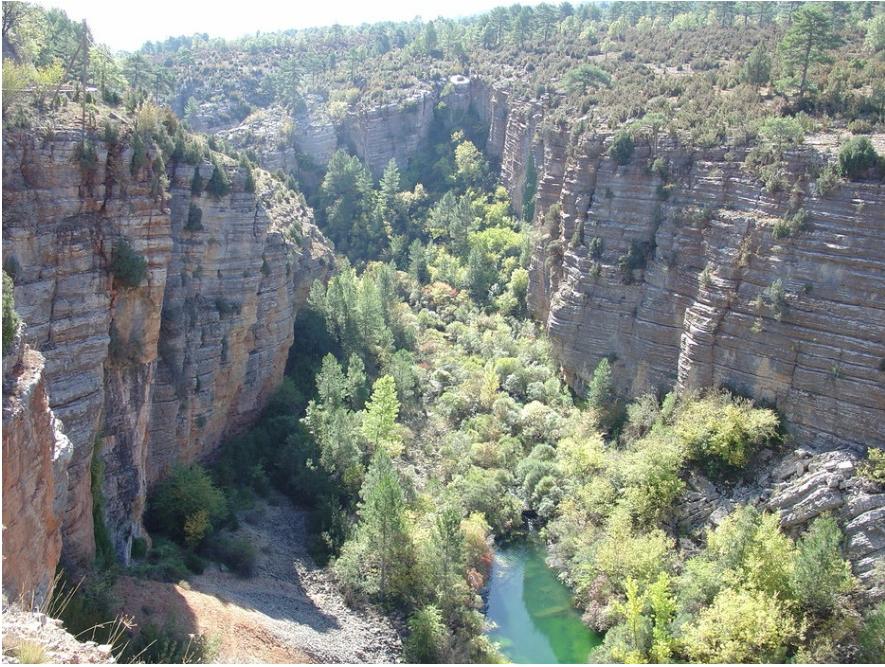
Figure 4. Serranía de Cuenca Natural Park. Source: www.turismocastillalamancha.es. (accessed on Figure 4. Serran í a de Cuenca Natural Park. Source: www.turismocastillalamancha.es (accessed on 15 21 October 2021) October